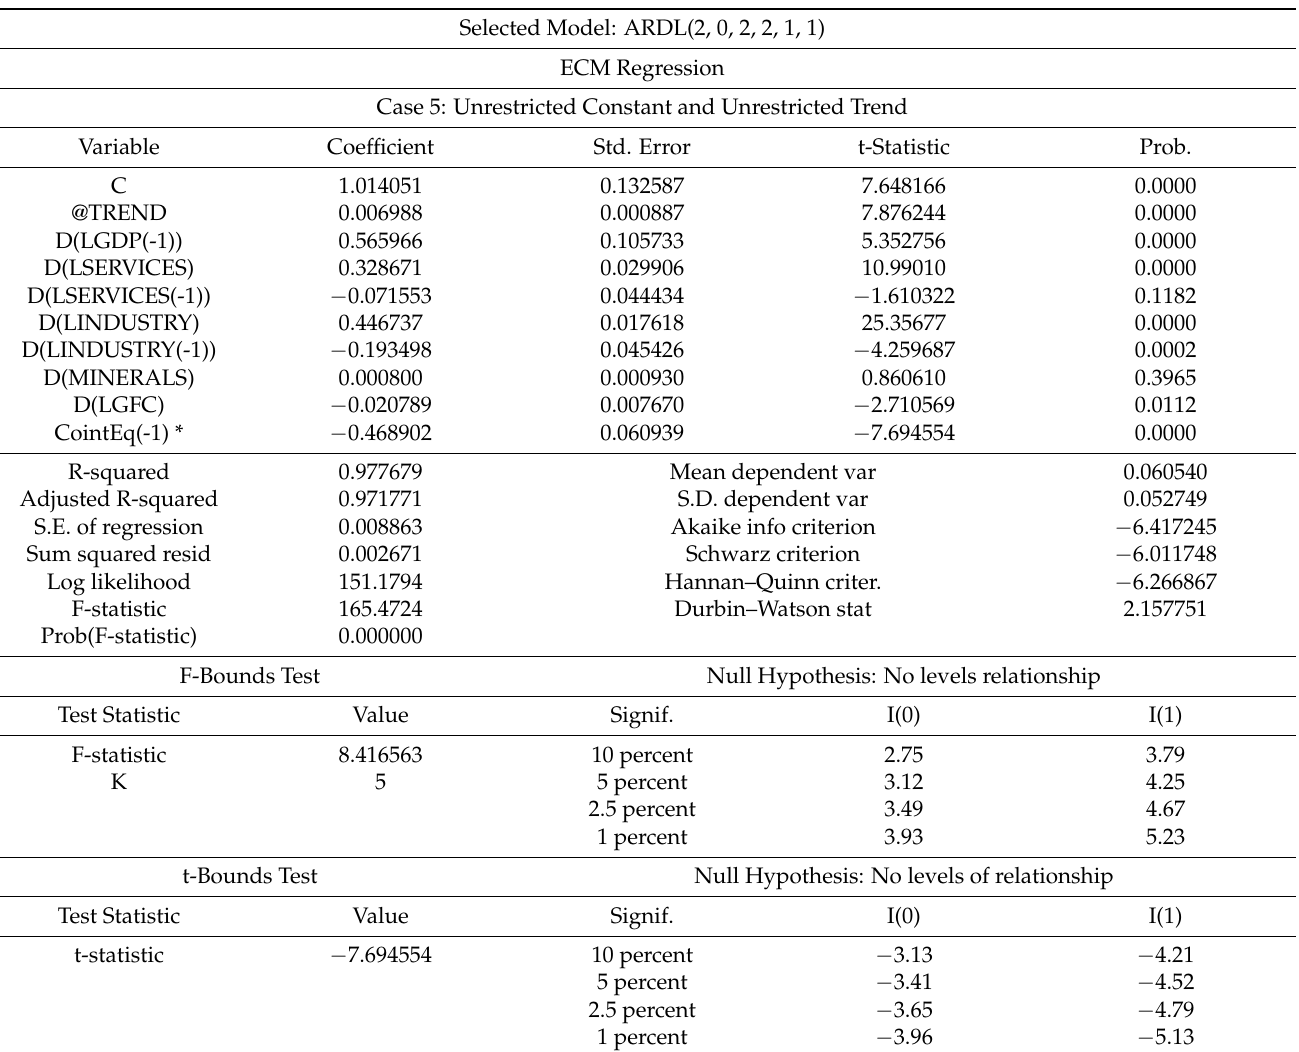
Table 5. ARDL error correction regression.